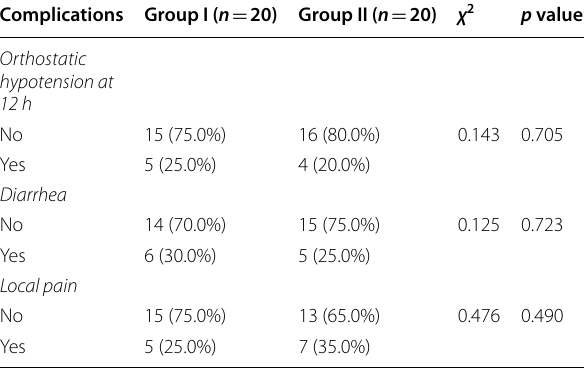
Table 3 Comparison between two groups according to